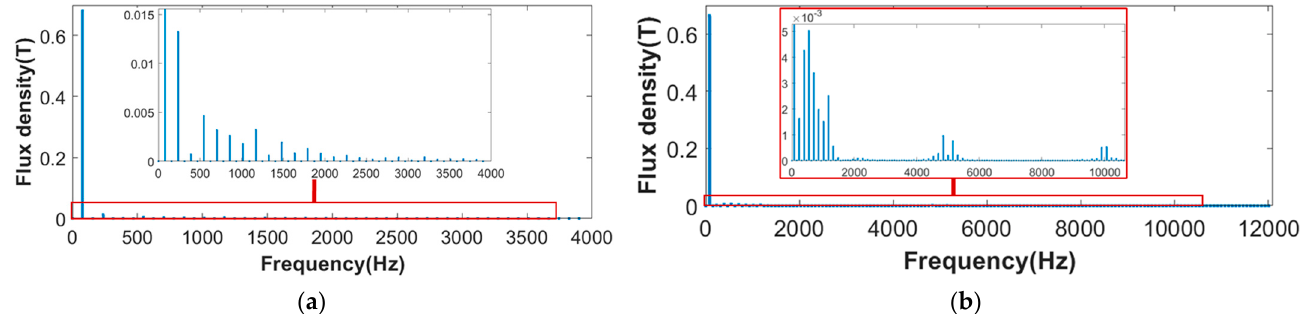
Figure 3. A-phase current spectrum under SVPWM drive.